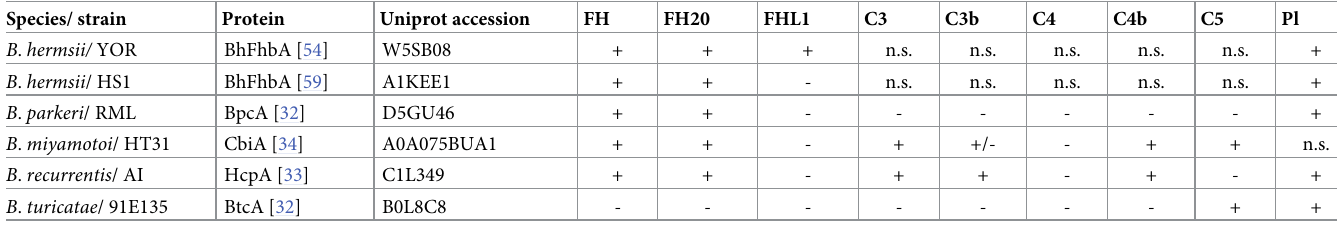
Consistent with our predicted binding mechanism, B . turicatae BtcA is the only FhbA-related protein of RF borreliaea that does not bind FH [32] (Table 4). Interestingly, there are three FhbA-related sequences in the borrelia from the LD clade, which cluster separately from the RF group (Fig 4B). Sequence data show that there are many deleterious alternations at the DNA level. It is not yet known, if these FhbA-related sequences are functional on a protein level. Analysis of all available sequence data from borreliae demonstrates that the LD clade has evolved to have three to four different classes of FH-binding proteins, whereas the RF clade has just one, which we name the FhbA-related protein family (Table 4). FhbA-related proteins may be able to inhibit complement more efficiently than the other FH-binding proteins, thus compensating for the lack of other FH-binding proteins. The interactions of FhbA-related pro- teins with other complement proteins (Table 4) might also affect overall regulation of comple- ment. It cannot be excluded that other, yet unknown, FH-binding proteins exist in relapsing fever spirochetes, or that some other complement evasion mechanisms, like binding of C4BP [57] or C1-inhibitor [58] provide enhanced protection. Table 4. Suggested interaction partners for the FhbA-related